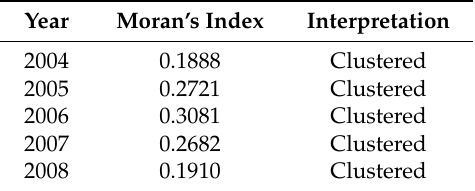
Table 1. Moran’s indices of TB incidences in Si Sa Ket,